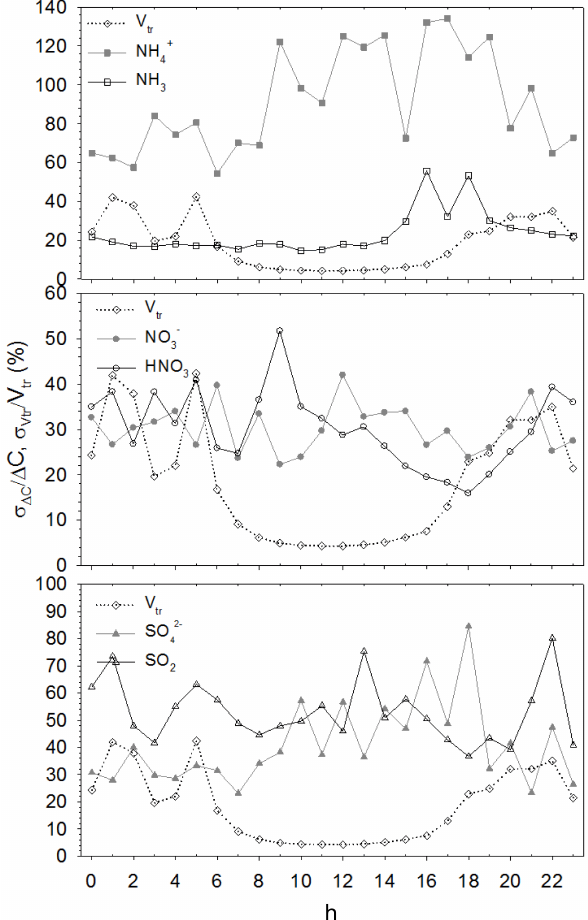
Figure 1. Diurnal profiles of uncertainty in chemical concentration gradients and transfer velocity expressed as a percentage of the cor- responding concentration gradient ( (cid:49)C ) and transfer velocity ( ν tr ) . Data points represent median value for the corresponding